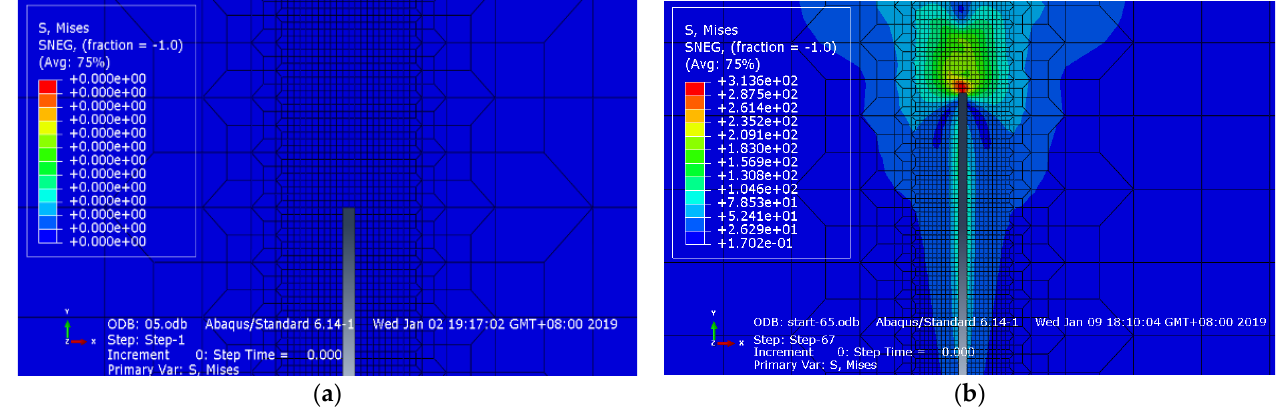
Figure 7. The initial stress distribution: ( a ) plate with prefabricated crack; ( b ) plate with fatigue crack (When cyclic tensile load unloading to zero).